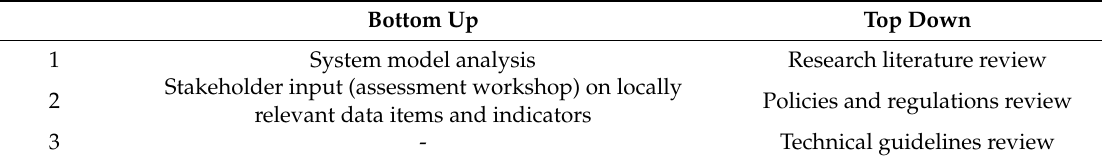
Table 1. Steps followed in the construction of the extended dataset framework.